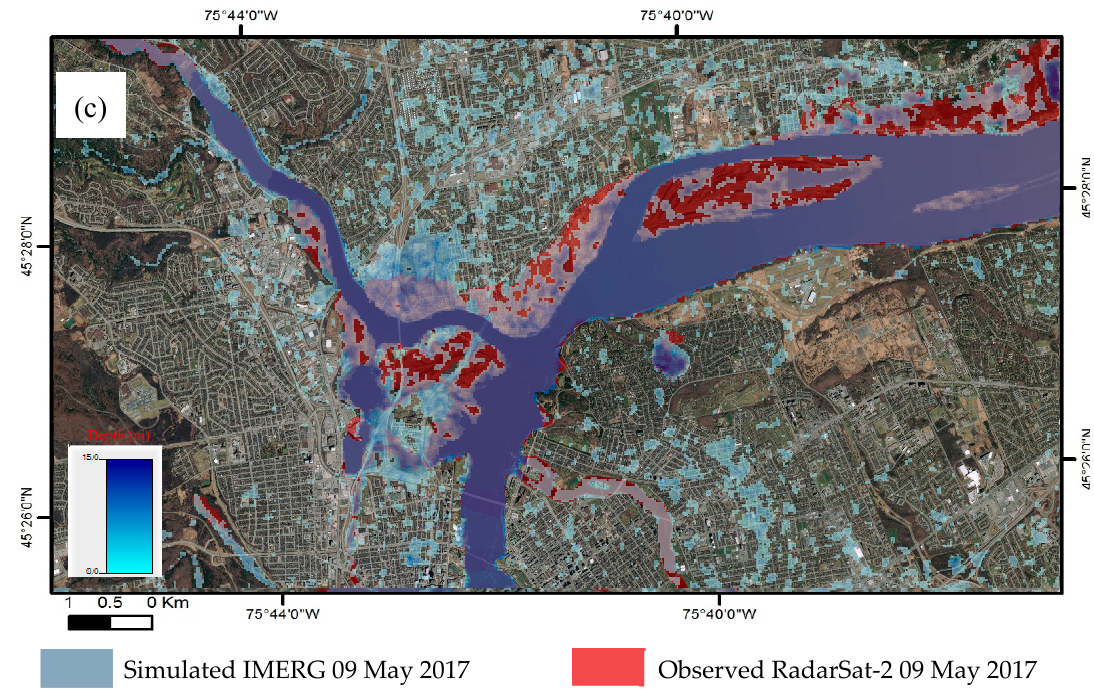
Figure 8. Accuracy assessment between the simulated maps and the observed flood extent. (a), (b) and (c) are zooms showing upstream, middle and downstream of the Ottawa River, respectively.